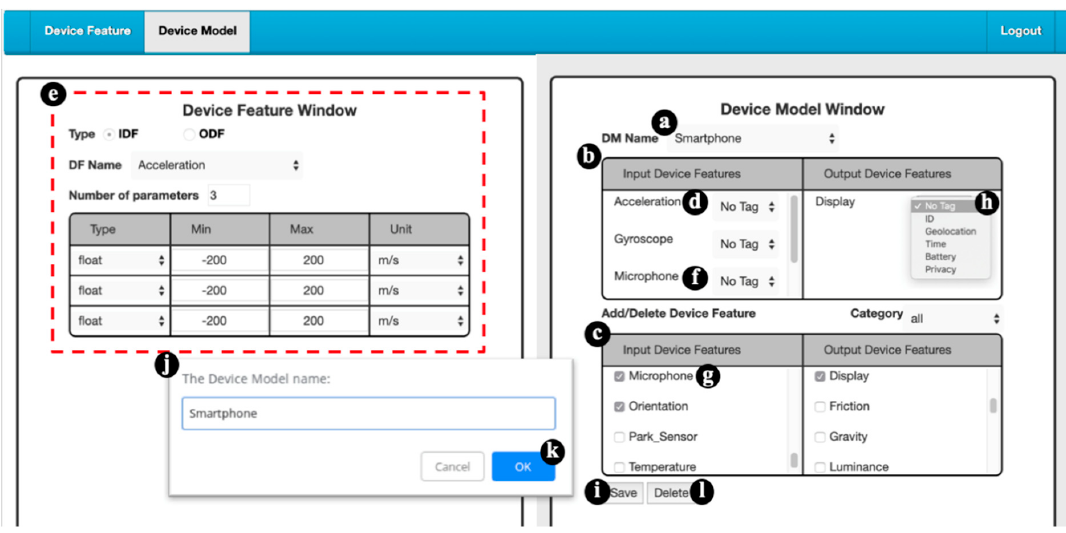
Figure A8. The Lum-I parameter record